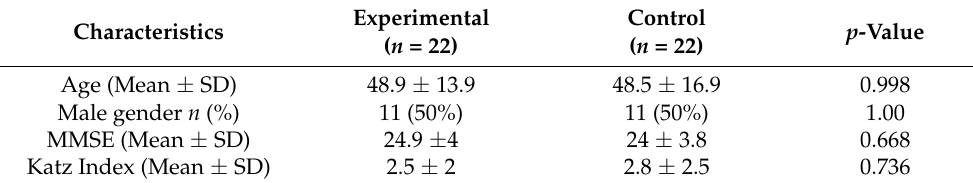
Table 1. Demographic and clinical characteristics.